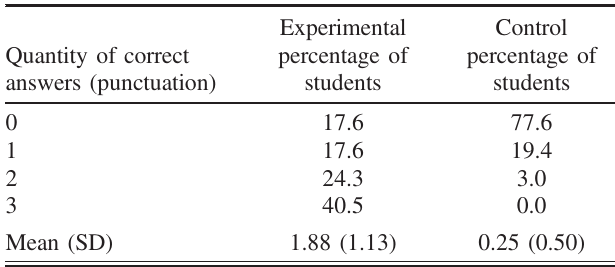
TABLE IV. Percentage of students from each group categorized by the quantity of correct